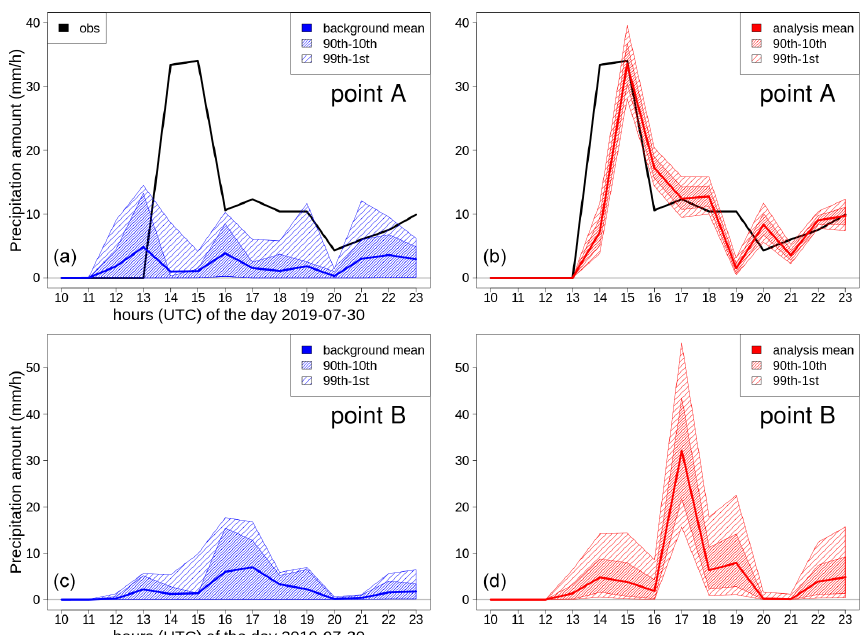
Figure 13. Time series of hourly precipitation totals for the period 30 July 2019, 10:00 to 23:00UTC, at points A (a, b) and B (c, d) in Fig. 7. Panels (a) and (c) show the background (blue). Panels (b) and (d) show the analysis (red). The blue (red) line shows the background (analysis) mean, the region with densely shaded lines is the difference between the 90th and the 10th percentiles, and the region with sparsely shaded lines is the difference between the 99th and the first percentiles. For point A, the closest observation, which is a radar-derived estimate, is shown (black line). Point B is in a region for which observations are not